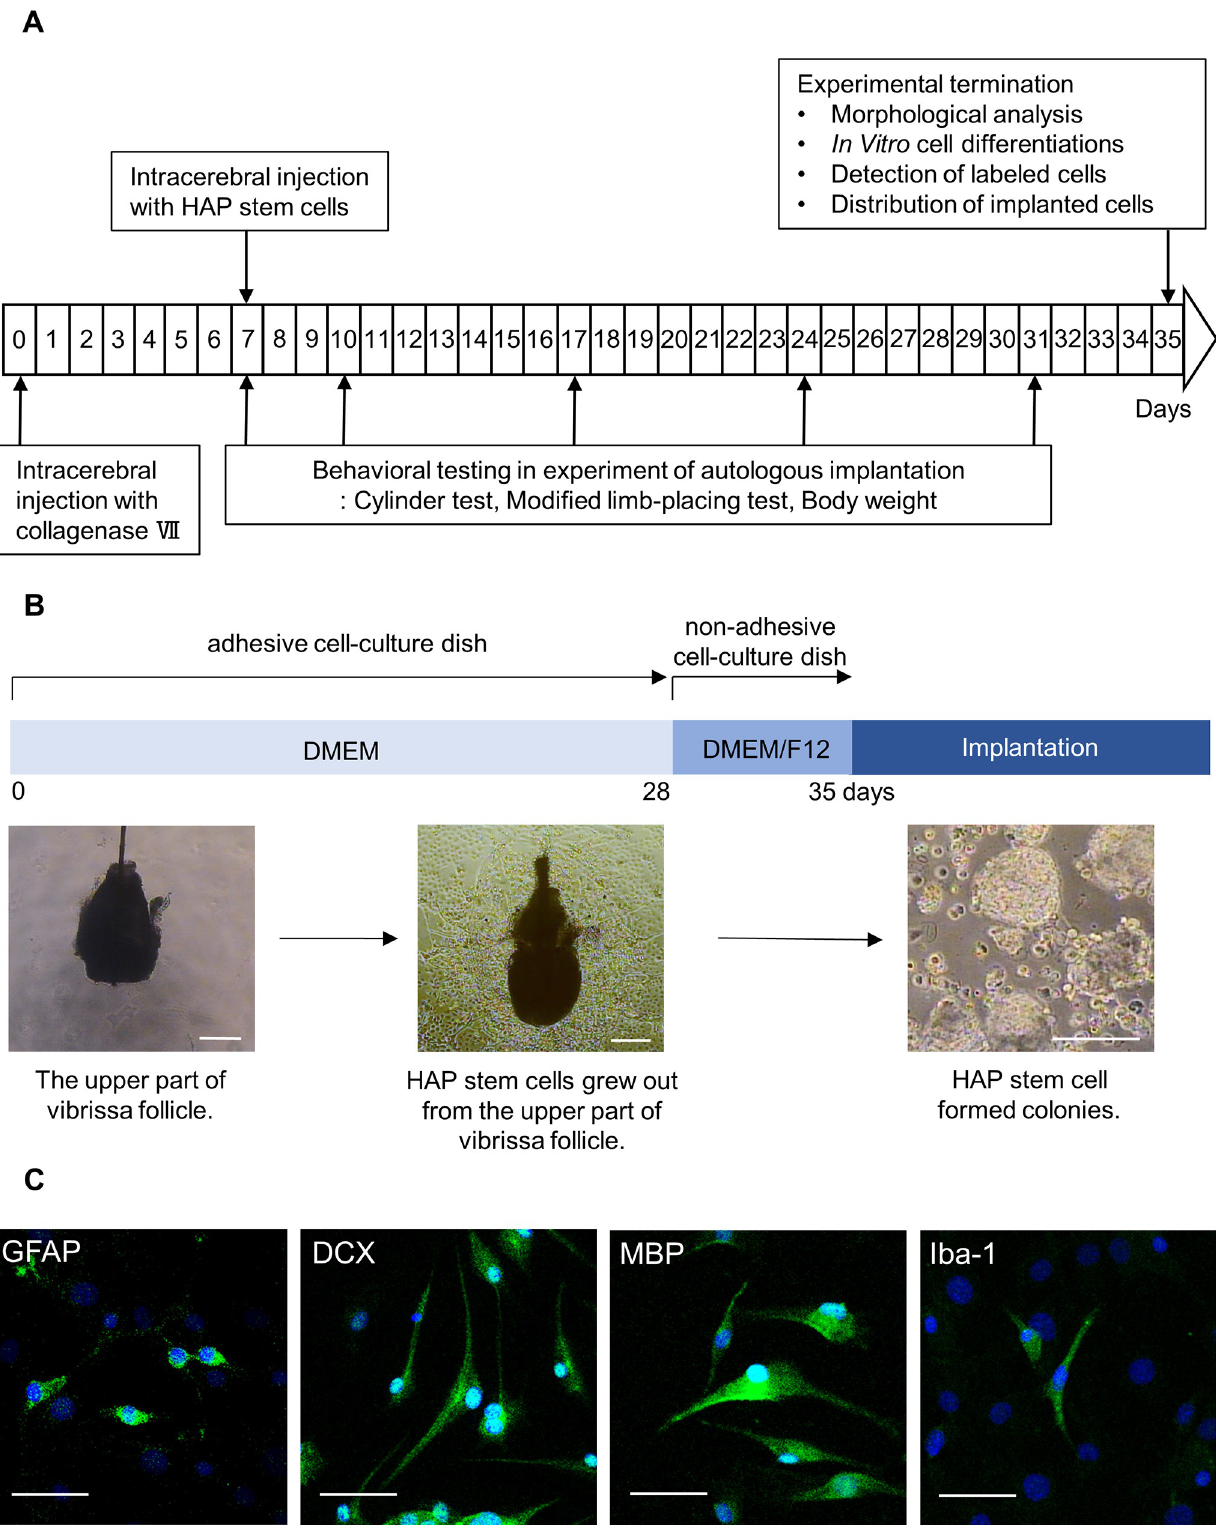
Fig 1. Experimental flow diagram and culture of HAP stem cells. (B) Procedure for culture and colonization of HAP stem cells. Bar = 200 μ m. (C) Immunofluorescence staining shows that the cultured HAP stem cell colonies differentiated to GFAP-positive astrocytes, DCX-positive neurons, MBP- positive oligodendrocytes and Iba-1-positive microglia on Lab-Tek chamber slides. Green = GFAP, DCX, MBP or Iba-1; Blue = DAPI. Bar = 50 μ m.